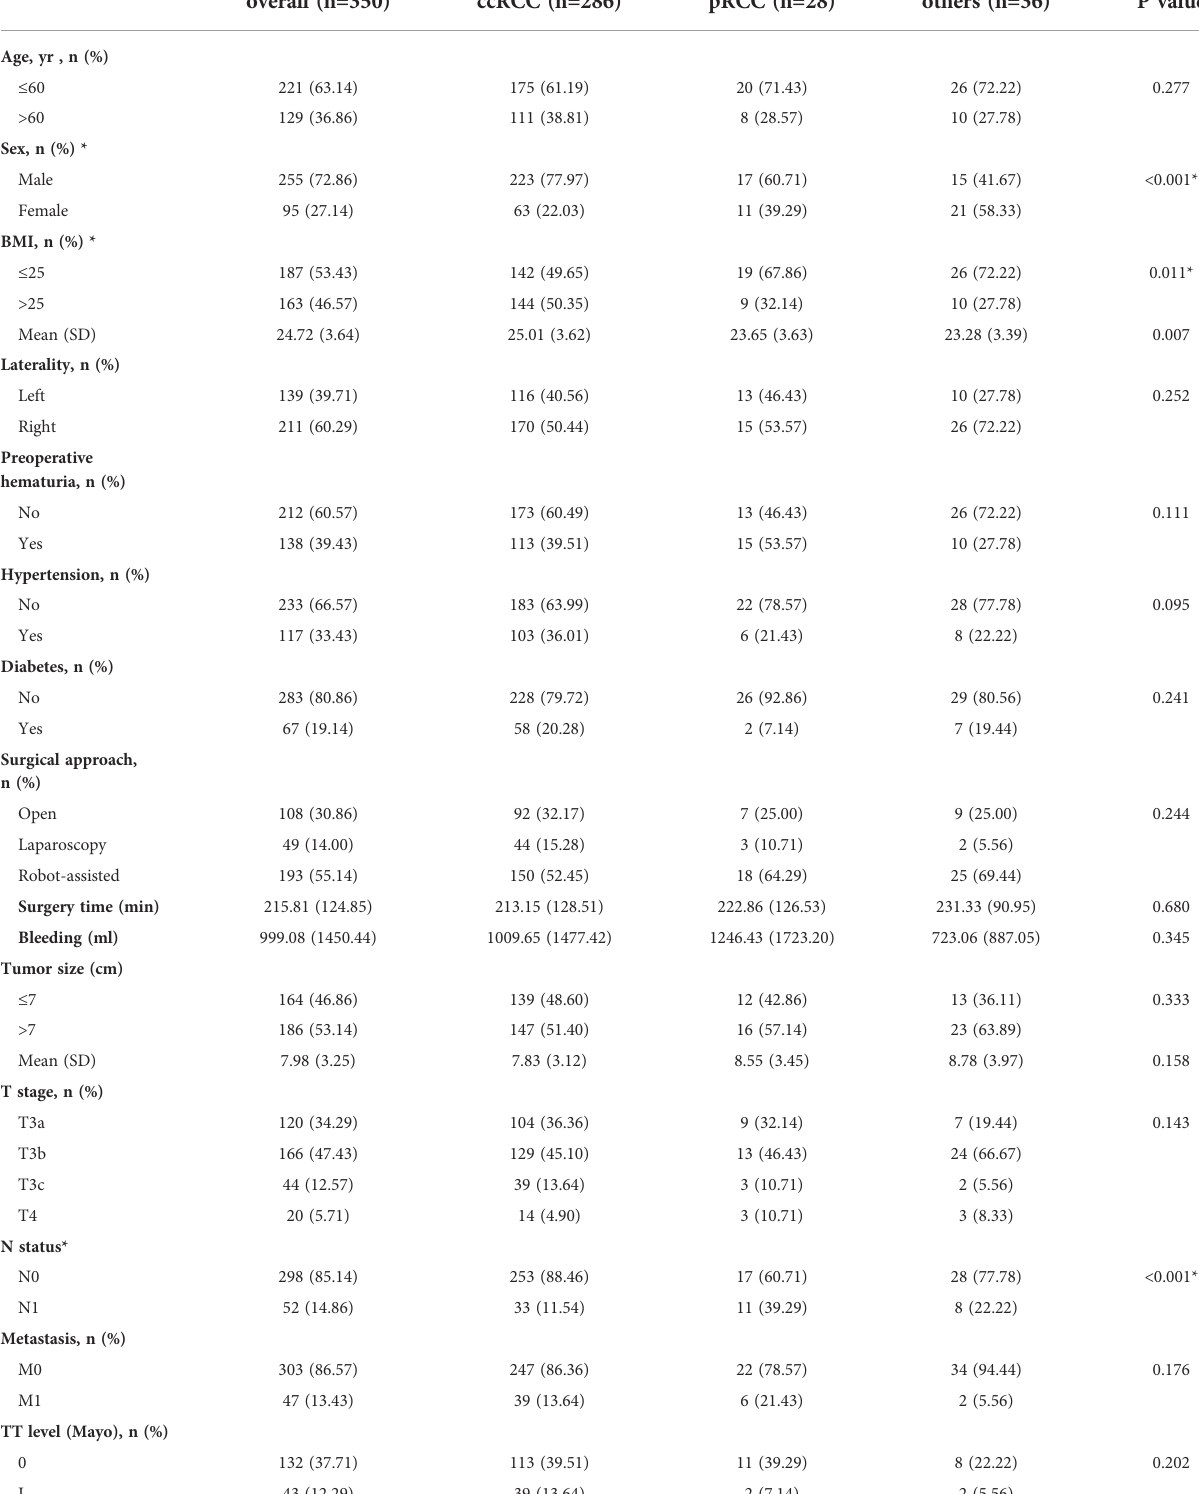
TABLE 1 Comparison of clinical and pathological characteristics between clear cell renal cell carcinoma, papillary renal cell carcinoma and the other